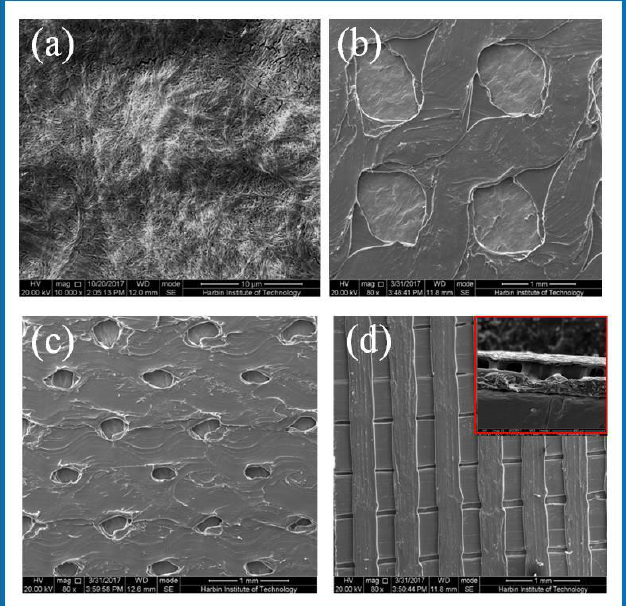
Figure 2. SEM images of BC membrane and 3D-printed PLA/BC composite films with three different surface microstructures at the same magnification of ( a ) pure BC membrane; ( b ) PLA/BC-1; ( c ) PLA/BC-2; ( d ) PLA/BC-3 (inset: cross section of PLA/BC-3).